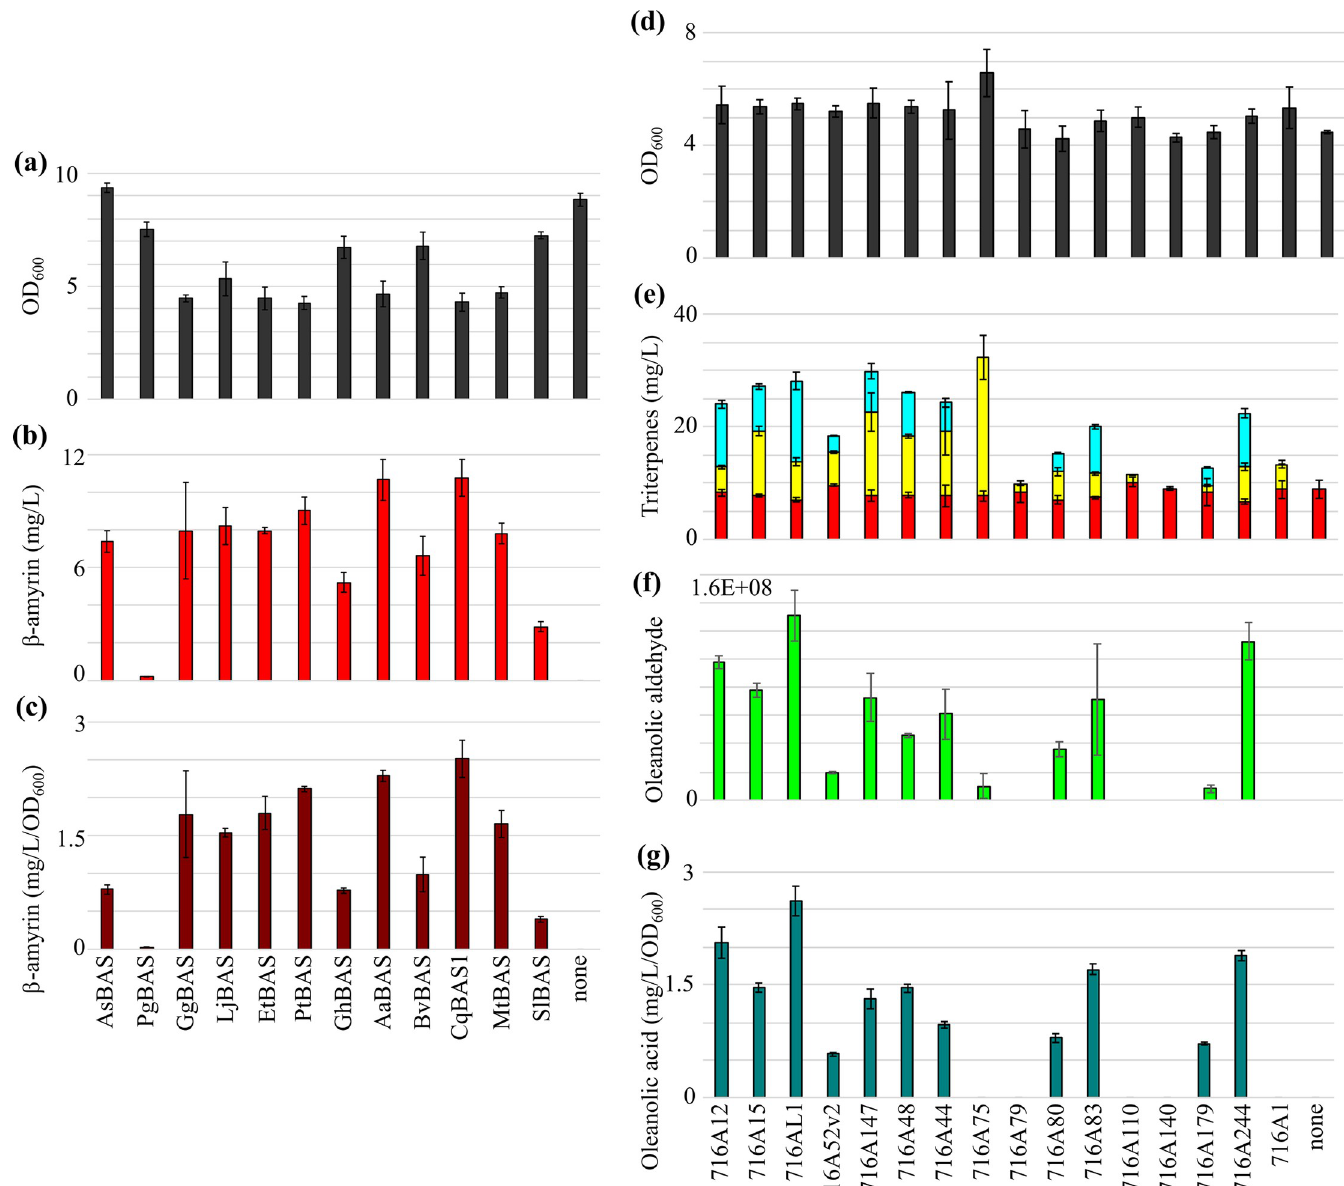
Fig 2. Comparison of BAS (a-c) and CYP716A (d-g) proteins for β -amyrin and oleanolic acid production. (a, d) OD 600 at end of culture (grey). (b, e) Titres (mg/L) of β - amyrin (red), erythrodiol (yellow) and oleanolic acid (cyan). (f) Oleanolic aldehyde peak areas obtained from GC/QTOF-MS analysis. (c, g) β -Amyrin (dark red) and oleanolic acid (dark cyan) productivities (mg/L/OD 600 ). None, empty vector strain MD-N1 in a-c and strain expressing AaBAS only in d-g. Mean ± SD for n = 3 is